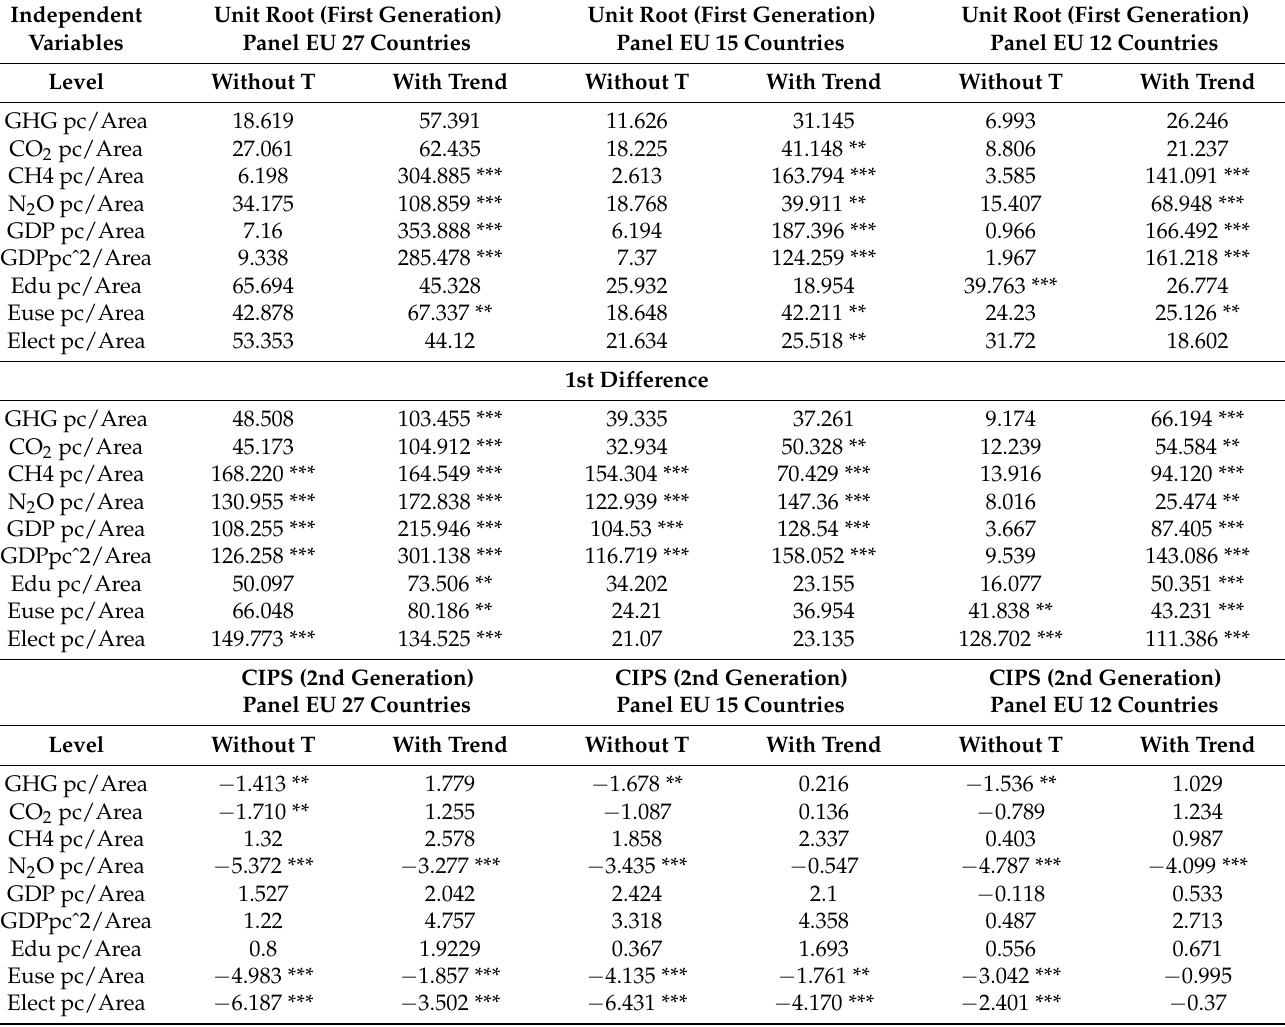
Table 3. Unit root test results for level and first differences, first and second-generation, by a panel of countries: EU 27, EU 15, and EU 12, with and without a